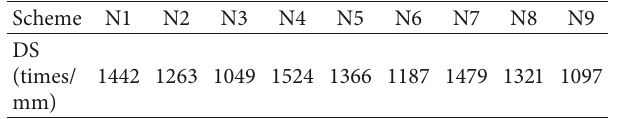
Table 7: Rutting test results.